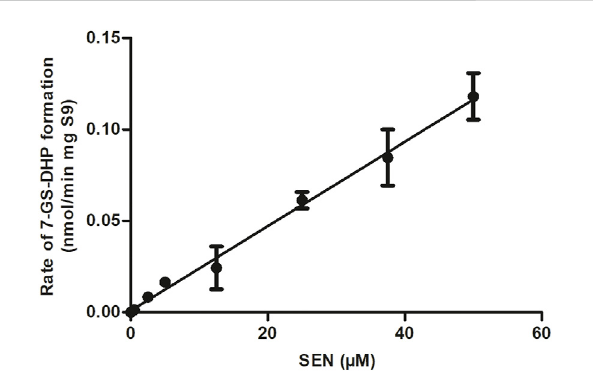
FIGURE 4 SEN concentration dependent rate of 7-GS-DHP formation in aerobic incubations with rat liver S9.Data are presented as mean ± SD of three independent experiments ( n =